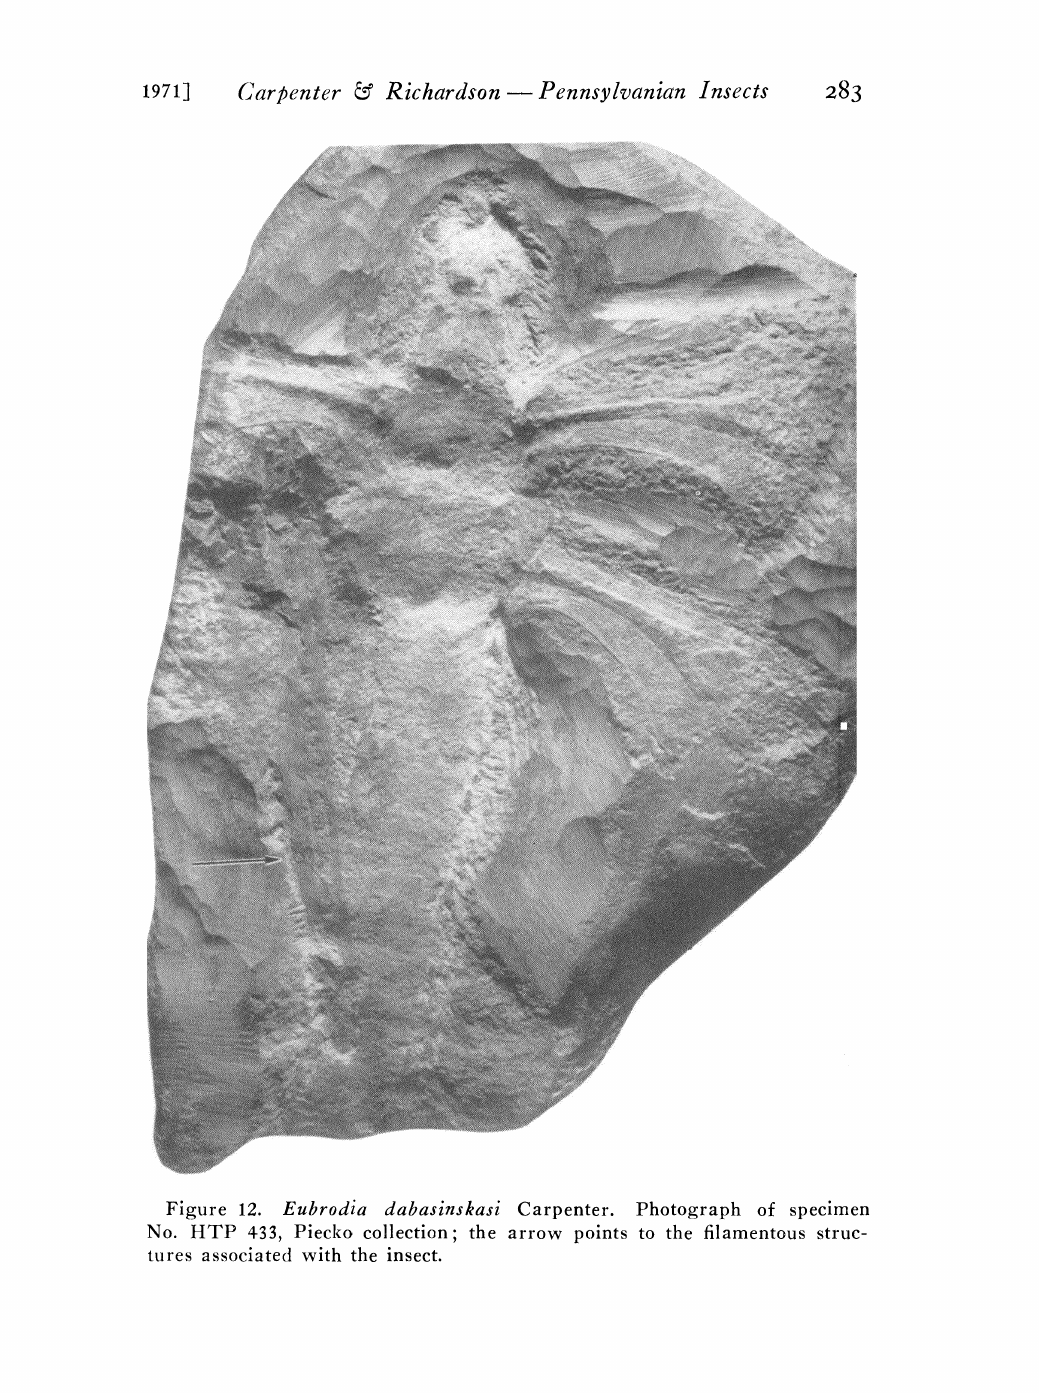
Figure 12. Eubrodia dabasinskasi Carpenter. Photograph of specimen No. HTP 433, Piecko collection; the arrow points to the filamentous struc- tures associated with the